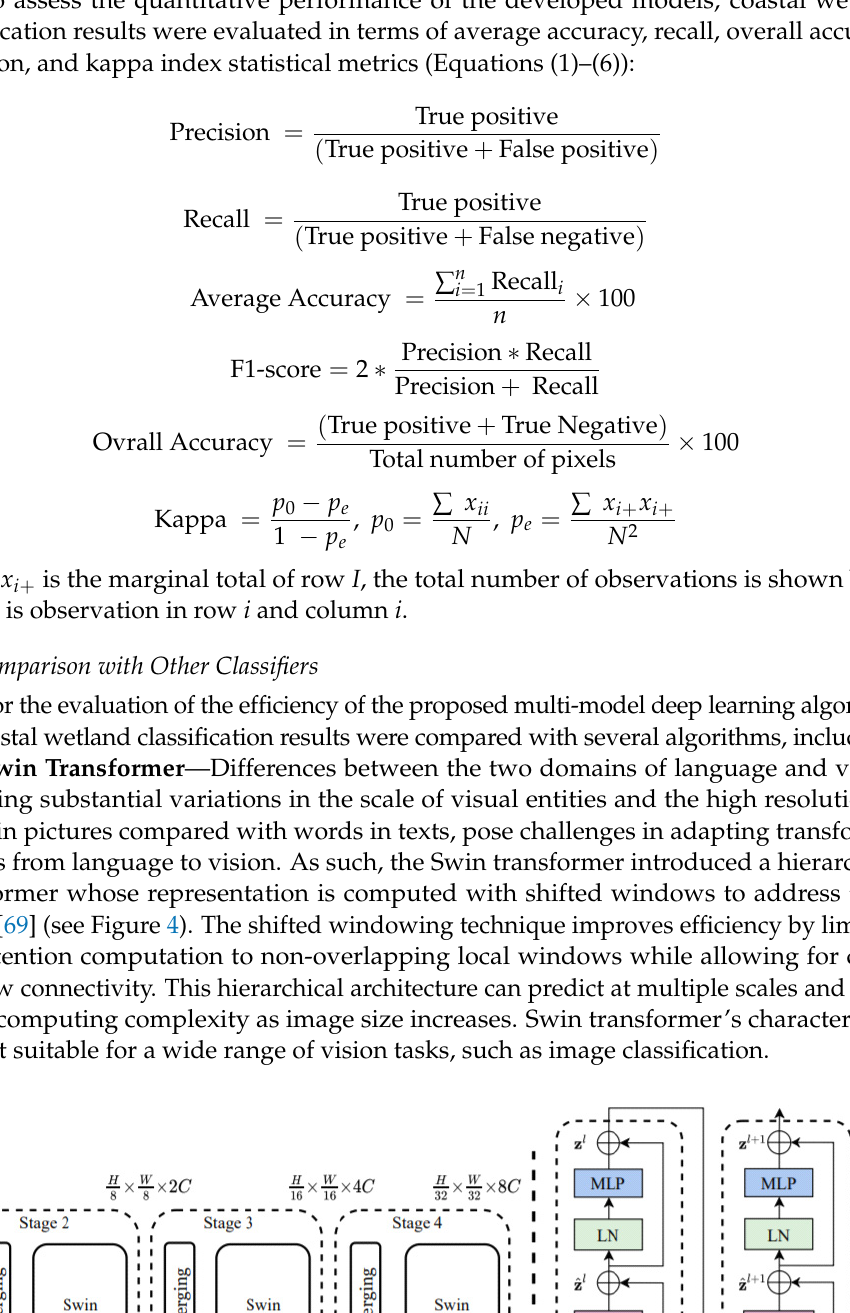
Figure 5. Illustration of high efficiency of batch computation for self-attention in shifted window partitioning [69]. Swin transformer blocks are computed consecutively using the shifting window partitioning method as (see Equations (7)–(10)): (cid:1878)̂ (cid:3039) = WMSA(cid:3435)(cid:1838)(cid:1840)((cid:1878) (cid:3039)(cid:2879)(cid:2869) )(cid:3439) + (cid:1878) (cid:3039)(cid:2879)(cid:2869)